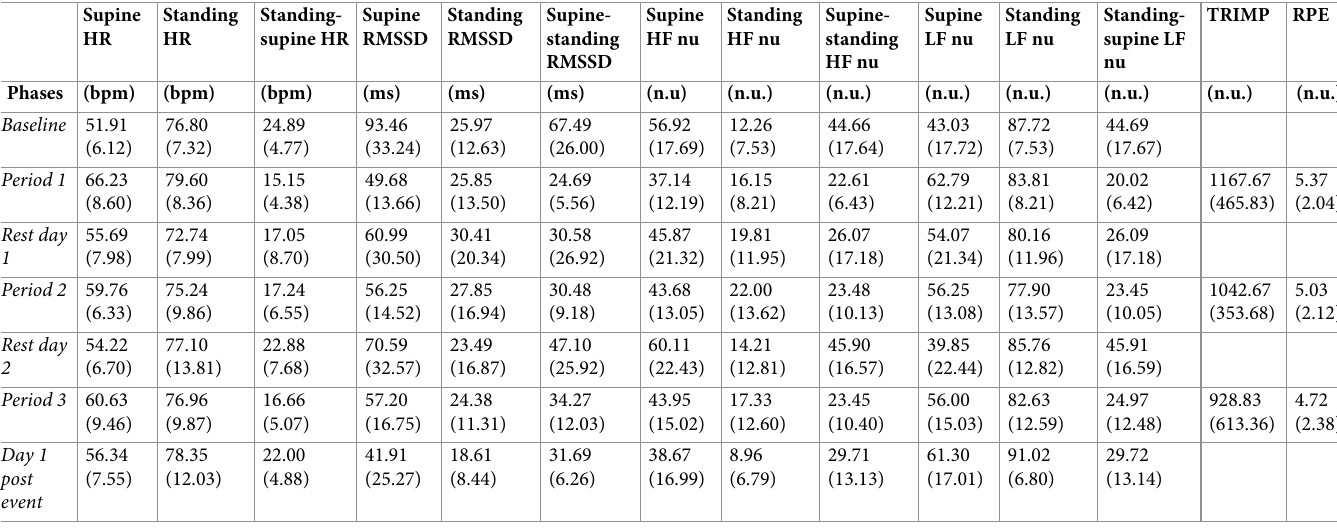
Table 4. Mean values ( ± SD) by period for 10 female cyclists during the 2017 Tour de France. Supine Standing Standing- Supine Standing Supine- HR HR supine HR RMSSD RMSSD